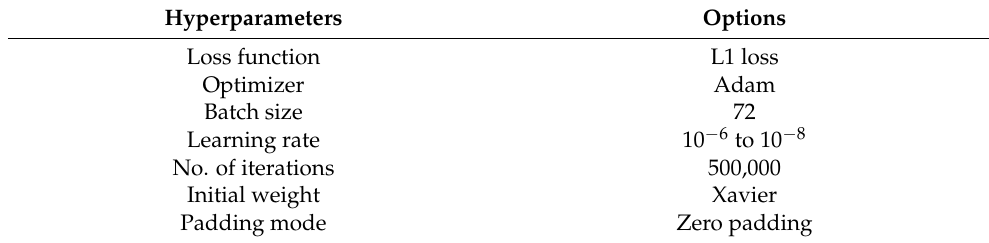
Table 5. Hyperparameters to train the proposed DCAN.